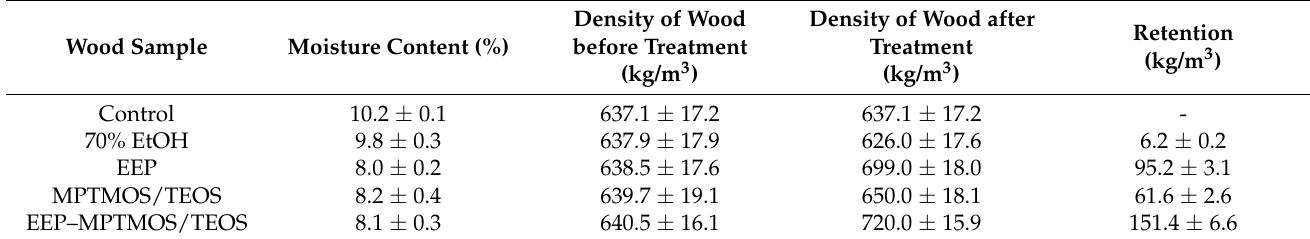
Table 1. Mean values of moisture content, density of wood before and after treatment, and retention of treated wood.